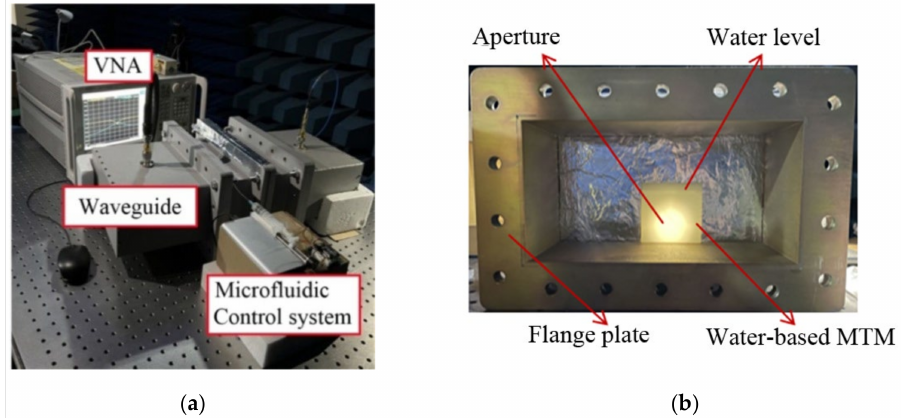
Figure 4. ( a ) The experimental platform and ( b ) the